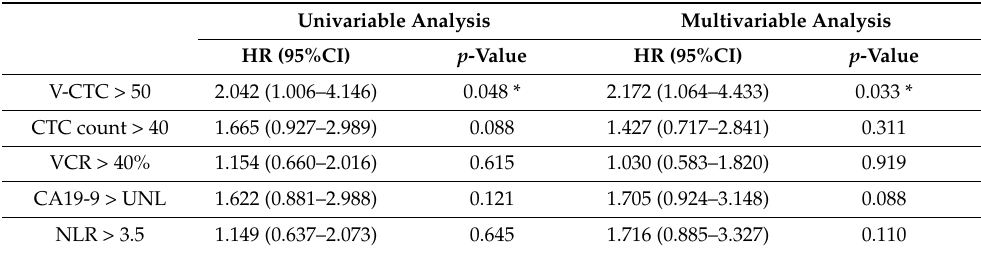
Table 4. Prognostic factor analysis via Cox regression